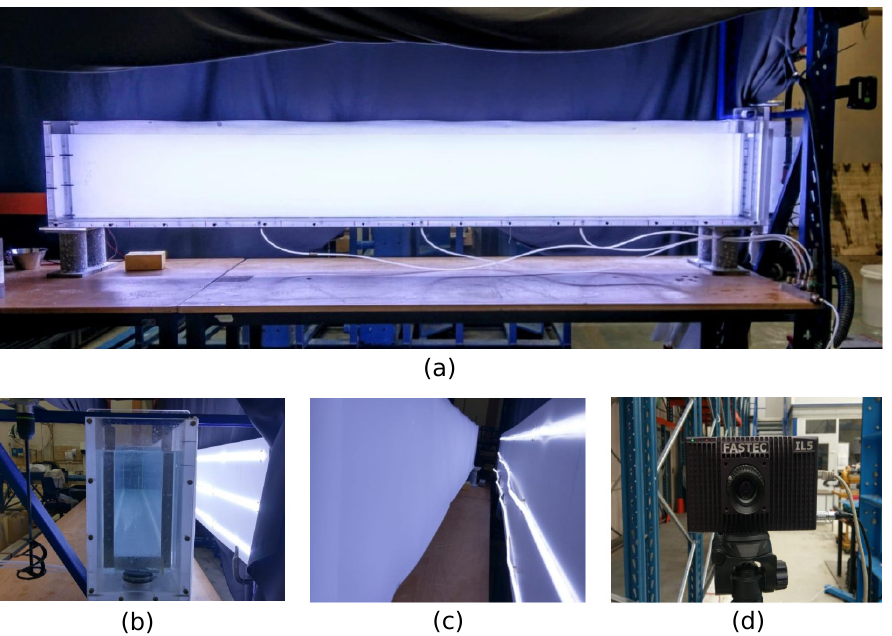
Figure 3. ( a ) Final setup of the tank with the diffused light. The black tent is used to create the maximum contrast; ( b ) side view of the tank setup showing wooden panel with LED stripes; ( c ) side view of the LED stripes and the diffused paper in front of it; ( d ) the high speed/definition camera used in the experiments.